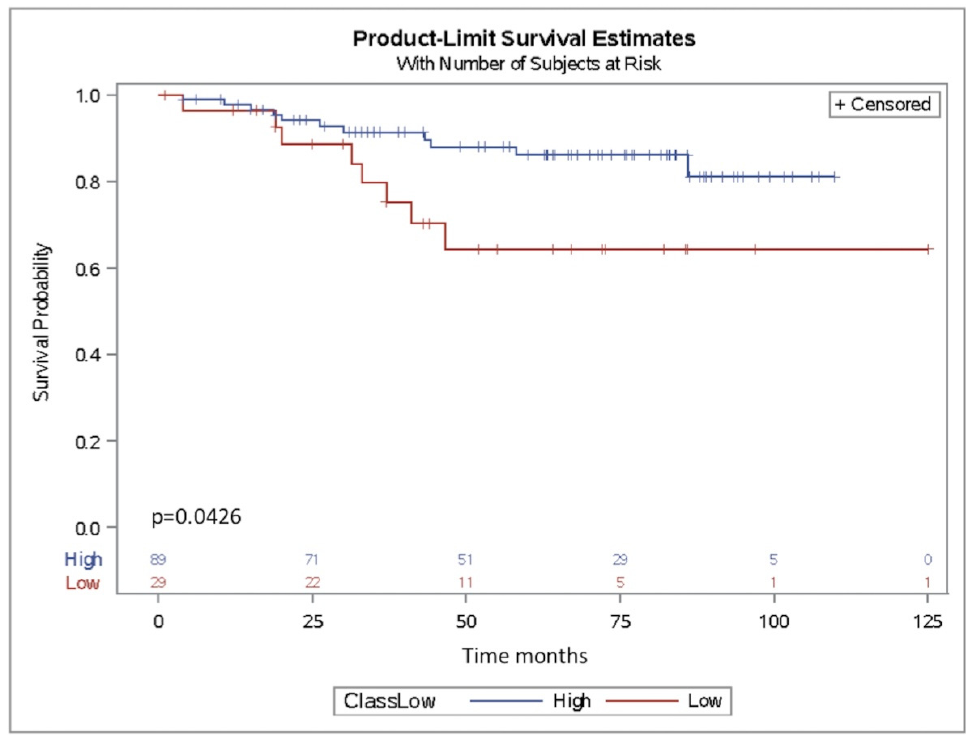
Figure 7. miR ‐ 302b as prognostic factor in TNBC patients. Kaplan–Meier survival curves of patients stratified according to miR ‐ 302b expression. Patients were dichotomized using first quartile as the threshold. Curves represent overall survival based on miR ‐ 302b expression ( p ≤ 0.05, log ‐ rank test).